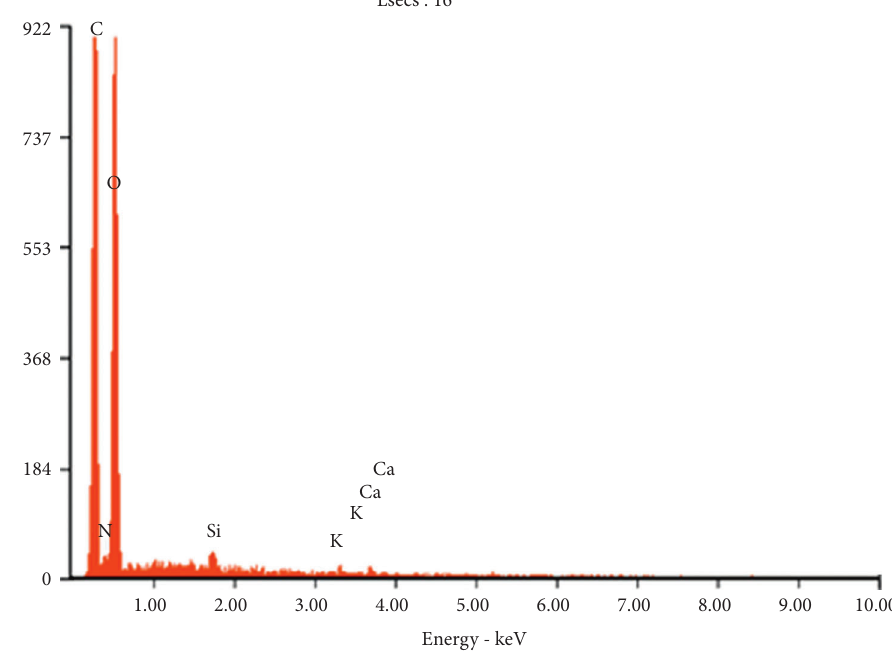
Figure 1: EDX spectrum of the bamboo specimen.